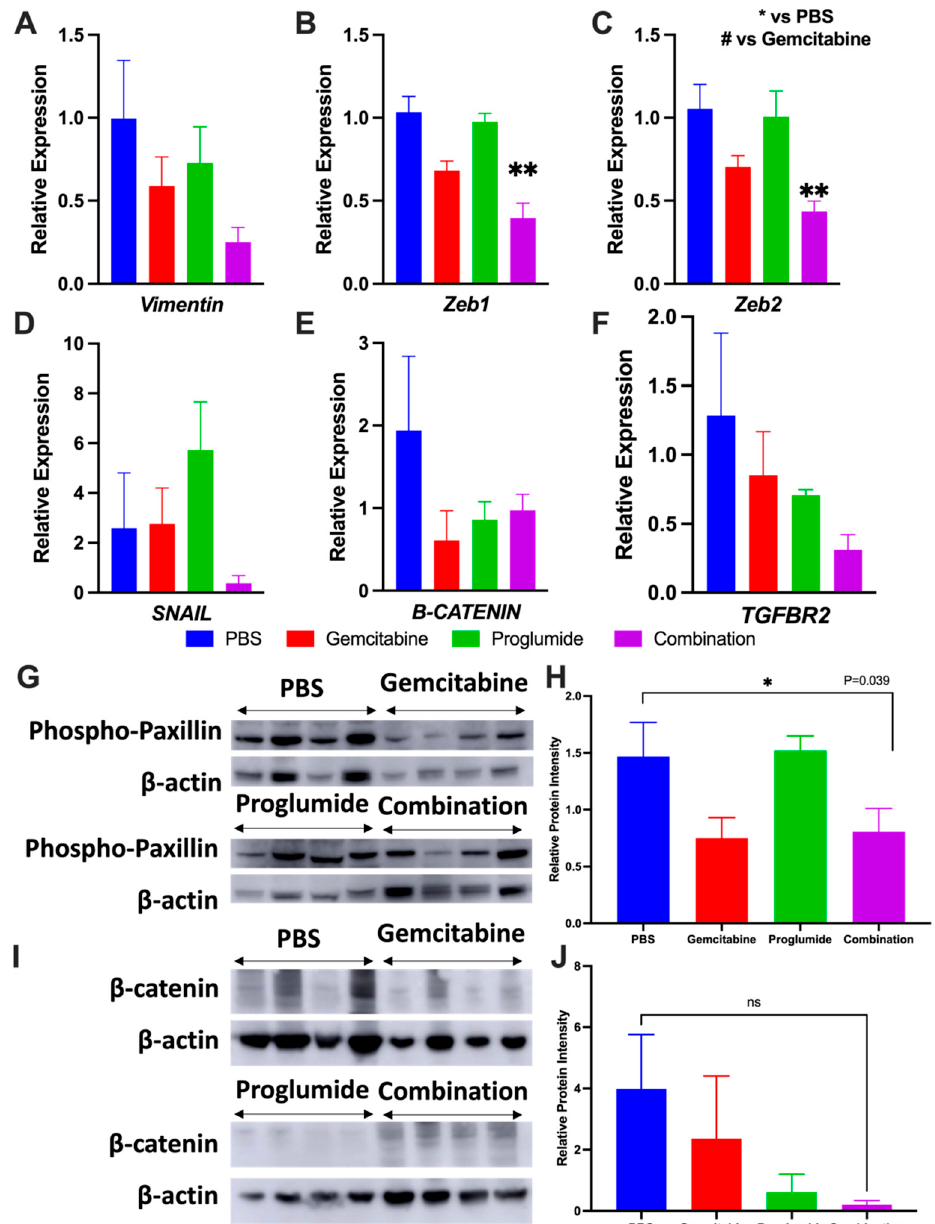
Figure 4. Combination therapy with gemcitabine and proglumide decreases metastases by preventing epithelial to mesenchymal transition (EMT). Quantitative PCR analysis for mRNA expression of transcription factors and proteins from PDAC tumors ( n = 4 per group) with relative gene expression (2 − ∆∆ Ct ± SEM) for: ( A ) Vimentin , ( B ) Zeb1 , ( C ) Zeb2 , ( D ) SNAIL1 , ( E ) β -CATENIN , and ( F ) TBF β R2 . Unpaired t-test was used for analysis (* p = 0.05; ** p < 0.01) and GAPDH was used as the loading control. ( G ) Western blot for phospho-paxillin for tumor protein extracts of each group normalized with β -actin. (The whole western blot is shown in the Figure S4). ( H ) Analysis of bands by densitometry show significant differences in the groups * p < 0.05. ( I ) Western blot of PANC-1 tumor protein extracts reacted with an antibody for β -catenin normalized with β -actin. (The whole western blot is shown in the Figure S4). ( J ) Analysis of the bands by densitometry show a decrease in the intensity of the bands in the proglumide and combination groups although this did not quite reach statistical significance.